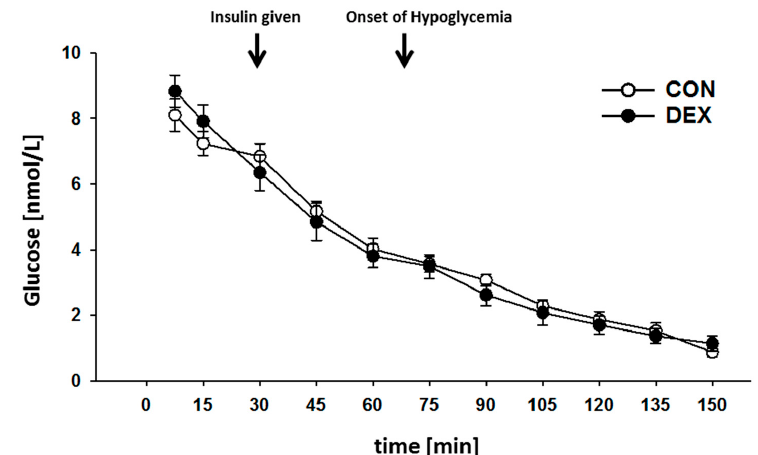
Figure 1. Blood glucose levels during hypoglycemic clamp. Blood glucose (mmol/L) measurements